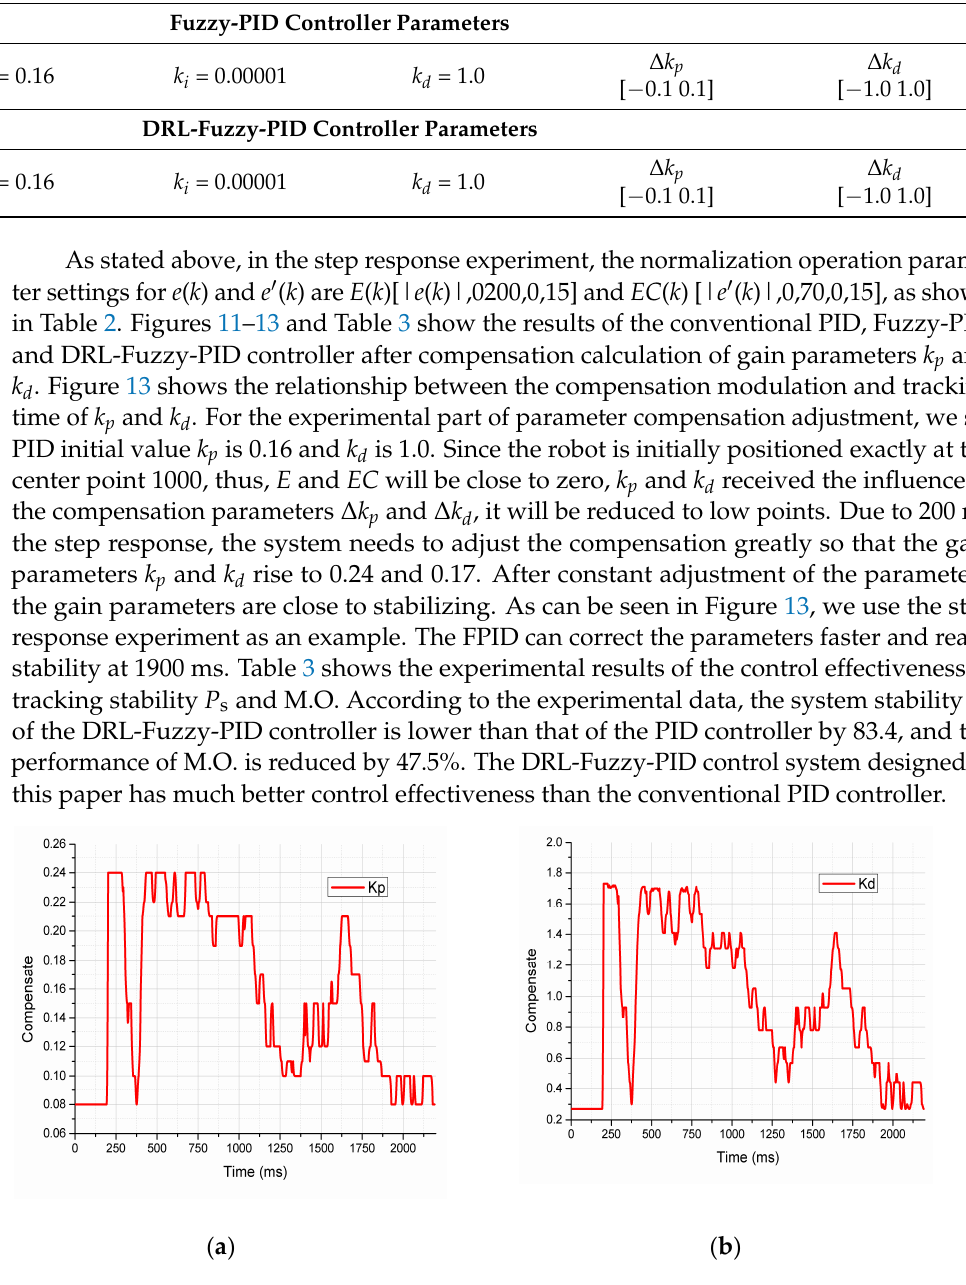
Figure 13. Position comparison diagram of DRL-Fuzzy-PID, Fuzzy-PID, and PID control in step response.